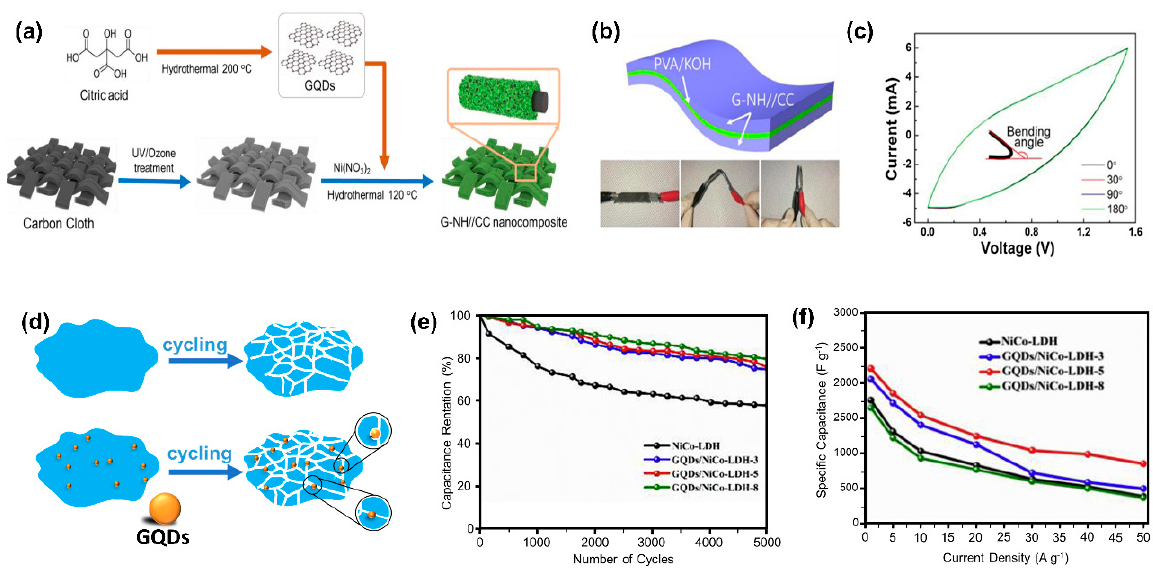
Figure 9. ( a ) Schematic illustration of the synthesis of GQDs/Ni(OH) 2 nanocomposites on a carbon cloth by the hydrother- mal method. ( b ) A symmetric supercapacitor of GQDs/Ni(OH) 2 on a carbon cloth at different degrees of bending states. ( c ) The CV results of GQDs/Ni(OH) 2 at different degrees of bending states: reproduced from Reference [153]. Copyright Elsevier, 2002. ( d ) the Role of GQDs as toughening materials in pseudocapacitors: GQDs also act as bridge of electron ( e ) capacity retention of various amounts of GQDs in nickel − cobalt Layered double hydroxide (LDH) over 5000 cycles at 20 A g − 1 . ( f ) Specific capacitance of all variations of GQD amounts in Ni − Co LDH: reproduced from Reference [100]. Copyright Elsevier, 2019.